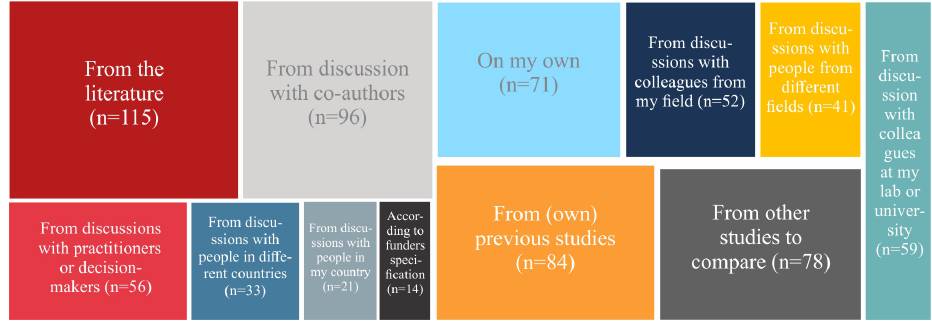
Figure 6. Responses to “How are your interviews, focus groups or questionnaires usually designed?”.